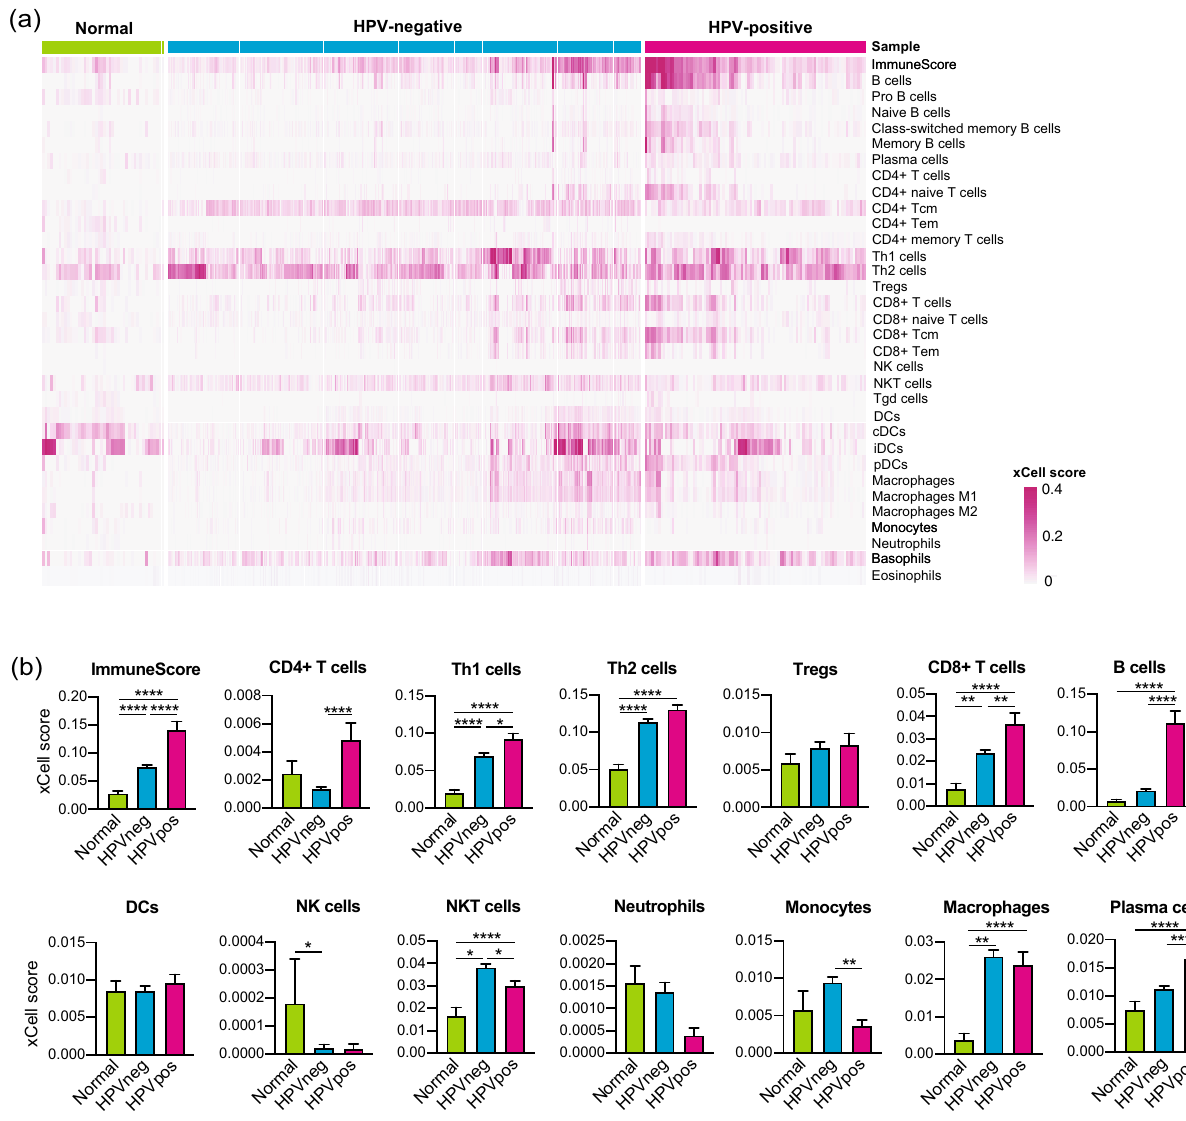
Figure 1. Enrichment scores of 33 immune cell types in normal tissues and HNSCCs. ( a ) Heat map of xCell enrichment scores of 33 immune cell types in 44 normal tissues, 97 HPV-positive HNSCCs, and 423 HPV- negative HNSCCs of TCGA cohort. ( b ) Bar graphs of enrichment scores of major immune cell types shown in ( a ). HNSCC Head neck squamous cell carcinoma, HPV Human papillomavirus, HPVneg HPV-negative, HPVpos HPV-positive, DC Dendritic cells. *, P < 0.05; **, P < 0.01; ***, P < 0.001; ****, P <